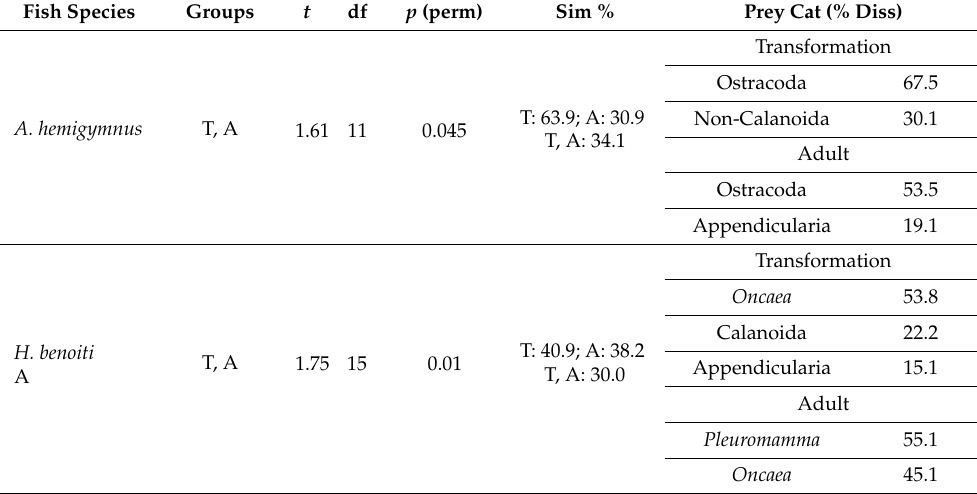
Table 4. PERMANOVA pair-wise tests between developmental stages (groups: transformation and adult including the juvenile stage) and within species. Only significant pair-wise tests are listed. Bray–Curtis similarity resemblance. Sum of squares Type III. Unrestricted permutation of raw data (999). t : t -statistic; df: degrees of freedom; perm: permutations; sim %: percentage of average similarity between and within groups; and prey categories’ contribution to average dissimilarity percentages (% diss) considering a 90% cut-off (similarity percentage analysis, SIMPER) is shown on the right side of the